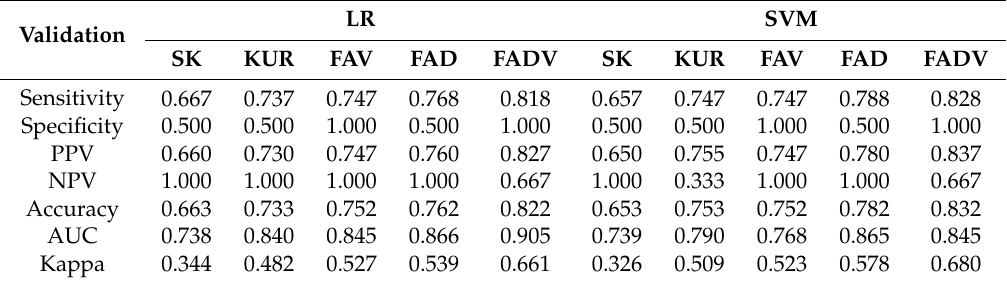
Table 5. The validation of classify model between LR and SVM in healthy, mild, and severe patient (n =